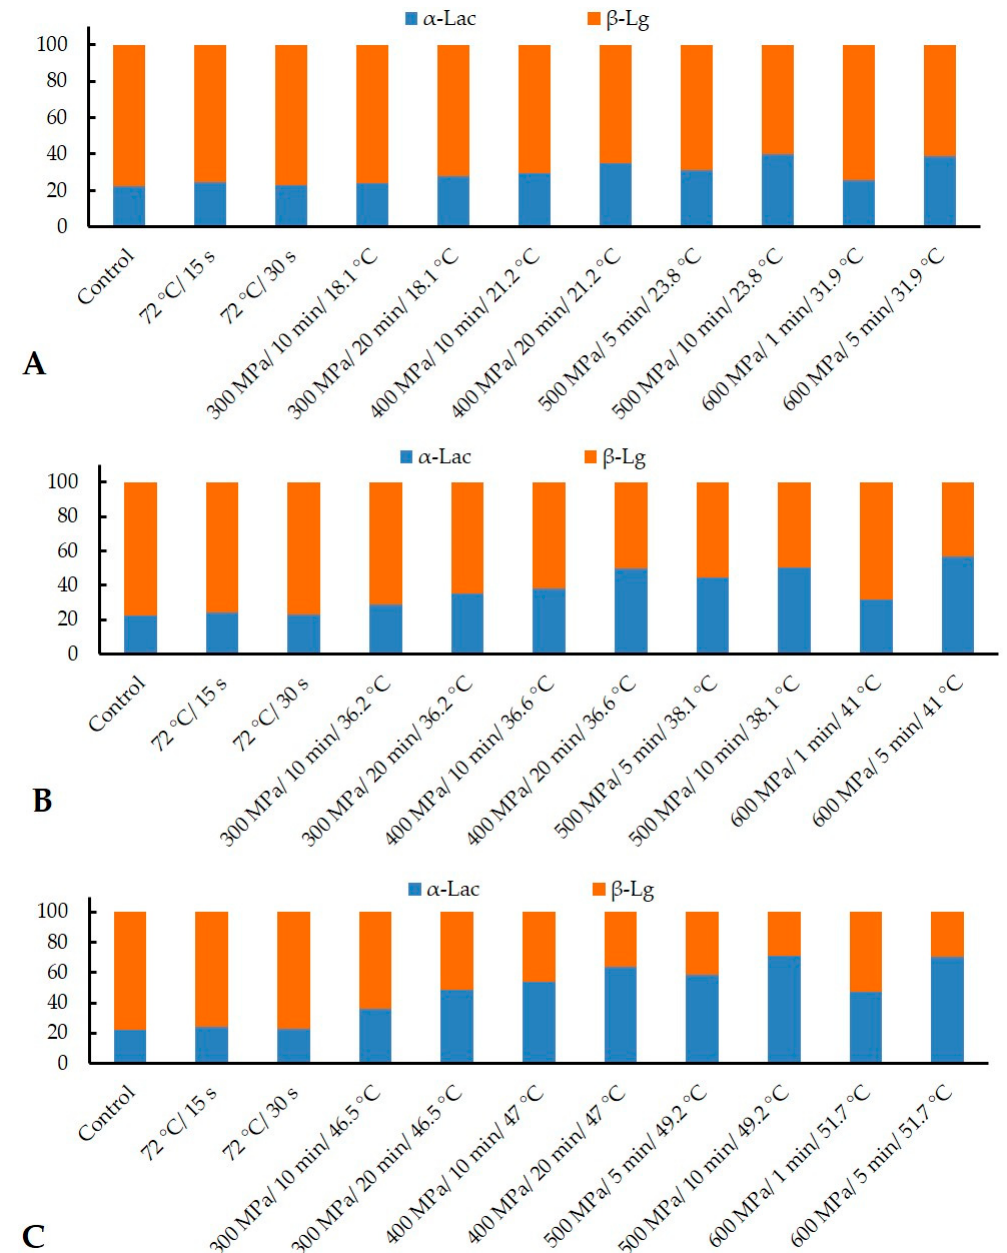
Figure 7. Relative proportions of α -Lac and β -Lg (%) after HTST at 72 °C for 15 and 30 s, and HPP applied at ~20 °C ( A ), ~30 °C ( B ), and ~40 °C ( C ). Total refers to the sum of α -Lac and β -Lg content.